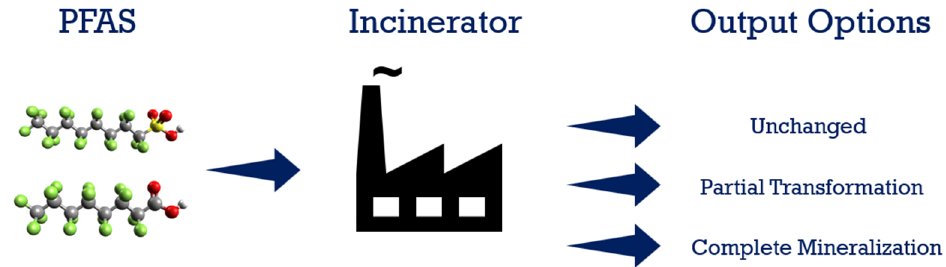
Figure 7. PFAS incineration.